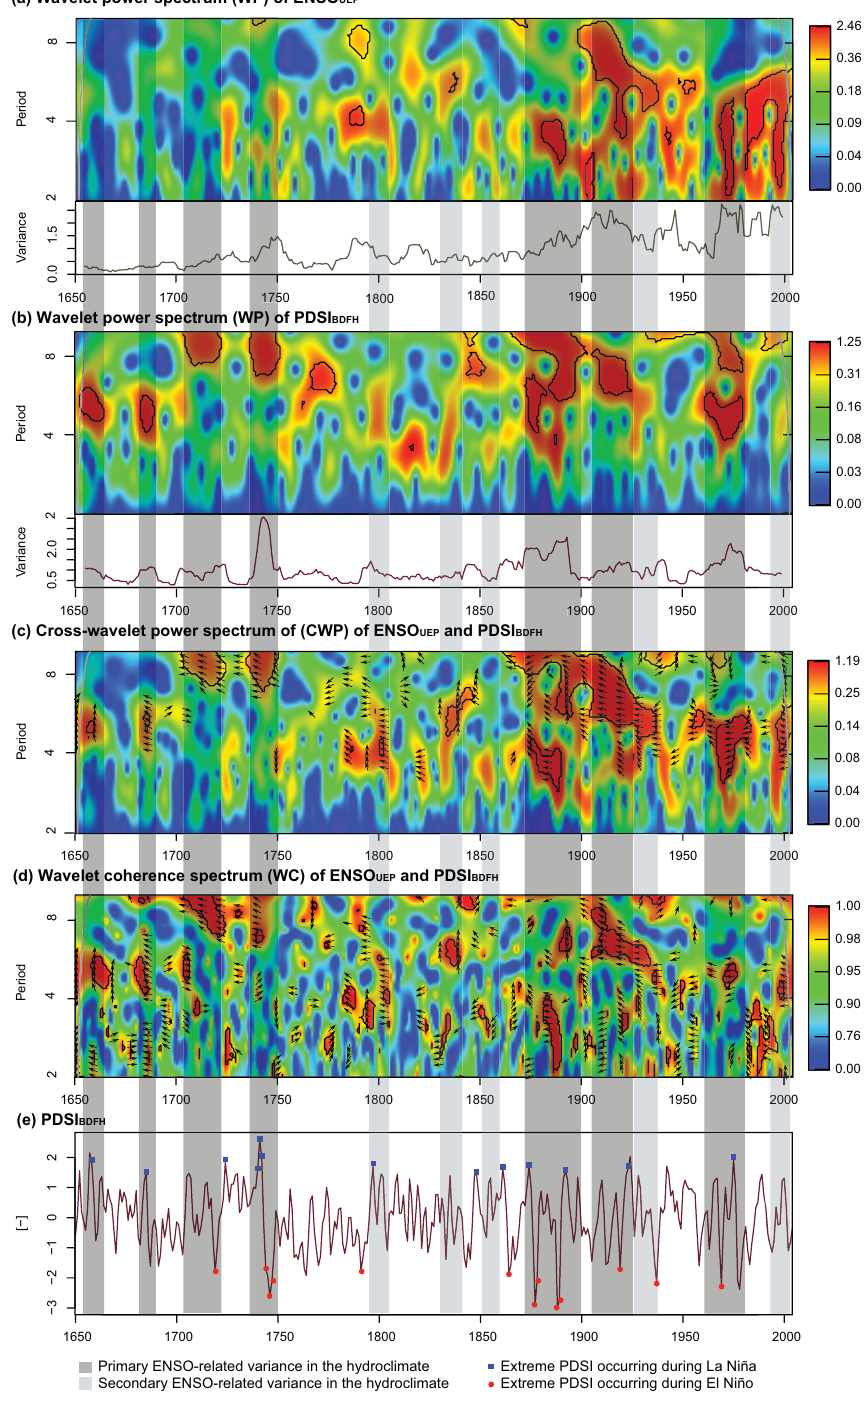
Figure 5. Wavelet analysis of ENSO and PDSI BDFH over the period 1650–2004. Wavelet power spectrum of (a) ENSO UEP and (b) PDSI BDFH , (c) cross-wavelet power spectrum and (d) wavelet coherence spectrum of ENSO UEP and PDSI BDFH , and (e) time series of PDSI BDFH . Tiles (a) and (b) also show total variances of time series calculated with a moving window of 21 years. The dark grey columns indicate periods with primary ENSO-related variance, and the light grey columns indicate periods with secondary ENSO-related variance in PDSI BDFH (see definitions in Table 2). Tile E also shows extreme PDSI values that occurred during ENSO events. Extreme values were defined from PDSI data as 5th and 95th percentiles. PDSI data describe the hydroclimate of the March–May